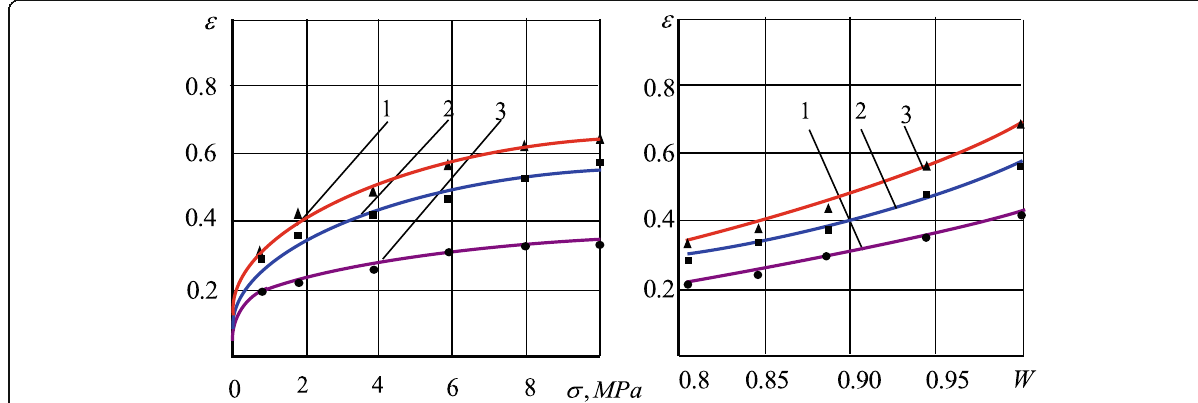
Fig. 5 Dependences of recovery strain ε of the belly section on compressive load. σ (1- W = 1; 2 − W = 0.94; 3 − W = 0.82) and moisture content W (1 − σ = 10 MPa ; σ = 6 MPa ; σ = 2 MPa